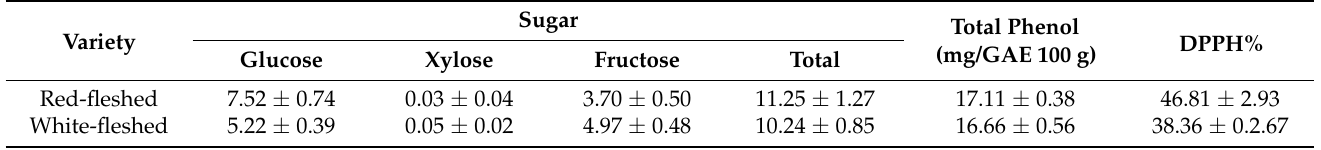
DPPH% (mg/GAE 100 g)